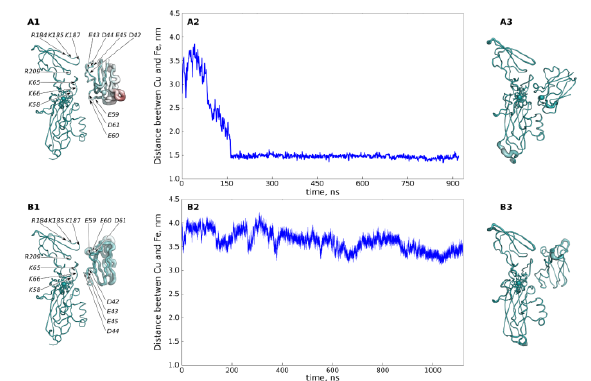
Fig.6. A1, B1: central structures of ‘productive’ (A1) and ‘unproductive’ (B1) clusters of diffusion-collisional (encounter) complexes of plastocyanin and cytochrome f from higher plants with an electrostatic energy of more than 8 kT. A2, B2: distance between copper and iron atoms of Pc and cyt f , obtained from MD calculations that have the productive (A2) and unproductive (B2) clusters as the initial structure. A3, B3: structures of the productive (A3) and unproductive (B3) final complexes obtained from MD calculations. Structures are painted by the value of the B-factor from emerald (0) to ruby (7263 Å 2 in A1, B1 and 2074 Å 2 in A3, B3). The thickness of the lines of protein structures is proportional to the value of the B-factor [23]